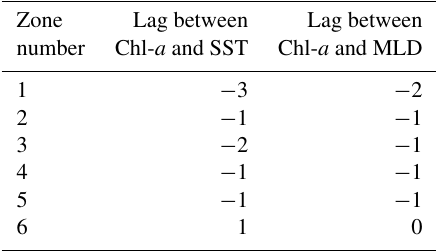
Table 2. Lag between peak Chl- a , SST and MLD in 8-day intervals. Zone Lag between Lag